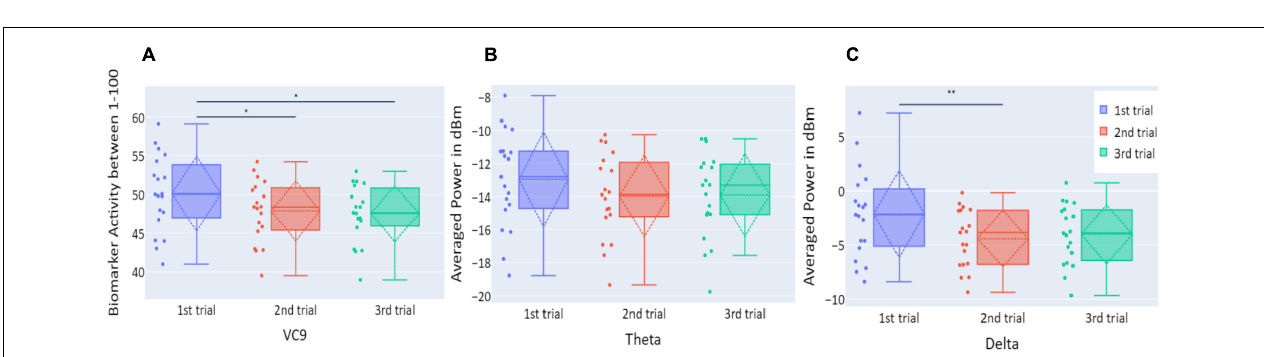
FIGURE 2 | The means of accuracy (in percentage), economy of movement (in percentage), and time to exceed the task (in seconds) obtained in the three trials of Experiment 1, as a function of task repetitions: first trial (blue), second trial (red), and third trial (green), for all participants ( n = 19). Error bars represent standard errors. ∗ p < 0.05, ∗∗ p < 0.01, and ∗∗∗ p < 0.001.